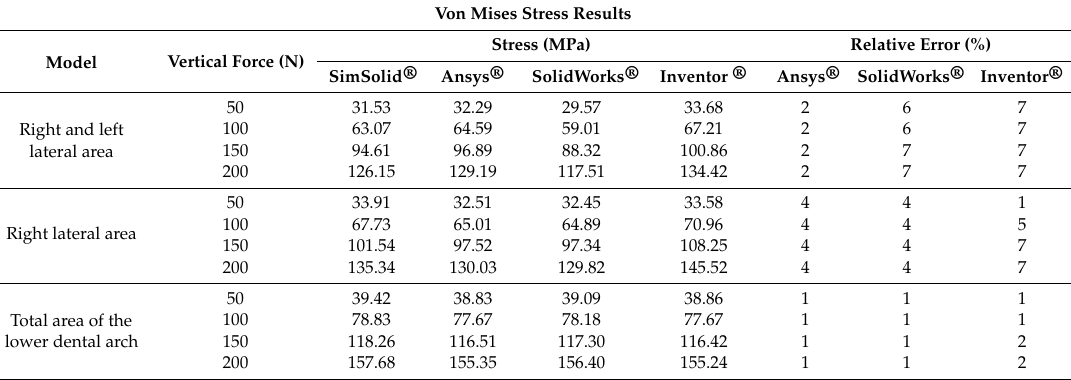
Table 3. Results of the von Mises stress and the percentage error between the software Ansys ® , SolidWorks ® and Inventor ® compared to the software SimSolid ® .